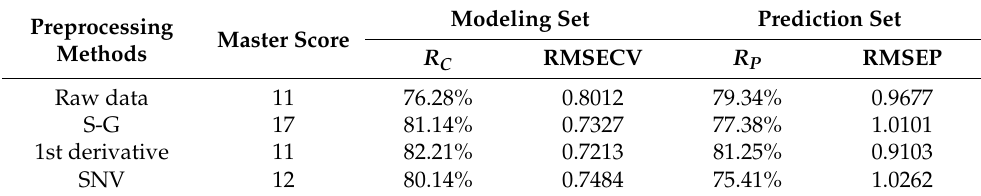
Table 3. Modeling effects of each pretreatment method.